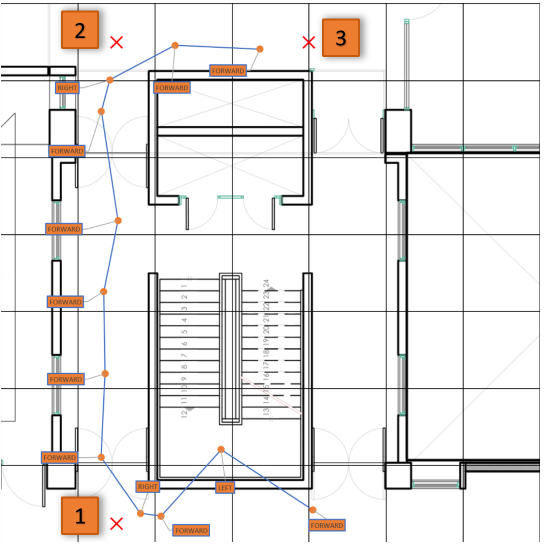
Figure 11. Single-floor navigation from point A to point B. The red X marks are the route points provided, and the labels represent the navigation modules instructions. An error in the localization estimation near point A results in an erroneous instruction from the navigation module.